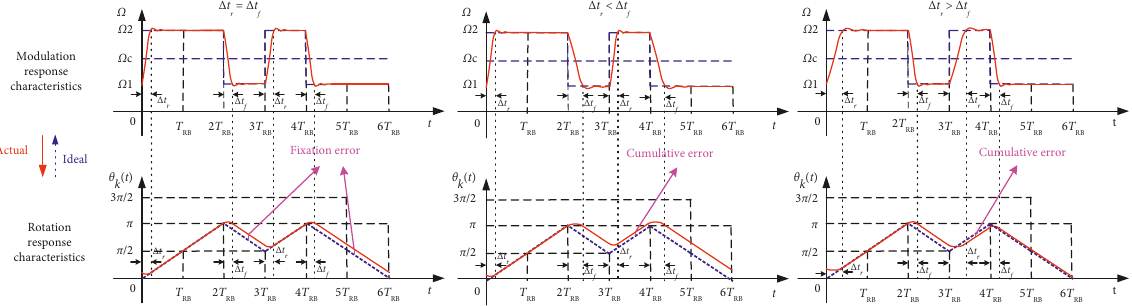
Figure 6: Phase change of